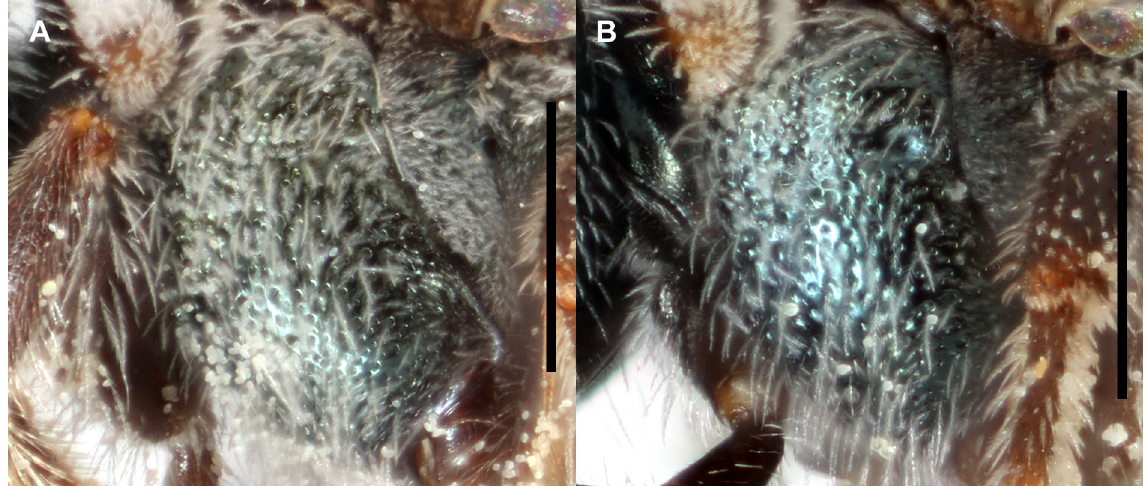
Fig. 84. Mesepisternum. A . Lasioglossum gloriosum sp. nov., ♀, with punctures very dense (IS ≤ 0.5 PD). B . L. indagator sp. nov., ♀, with punctures sparser (IS ≤ 1 PD). Scale bars = 0.5